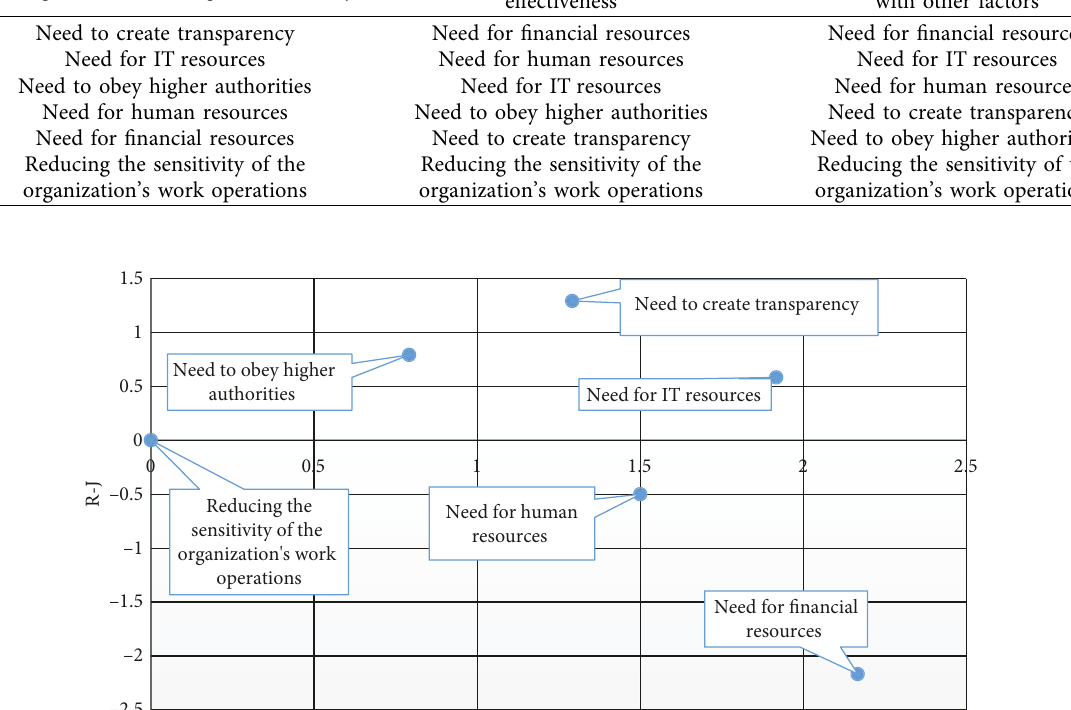
Table 3: Ranking of solutions based on the degree of causality, the degree of effectiveness, and the degree of interaction with other factors. Rank Ranking based on the degree of causality